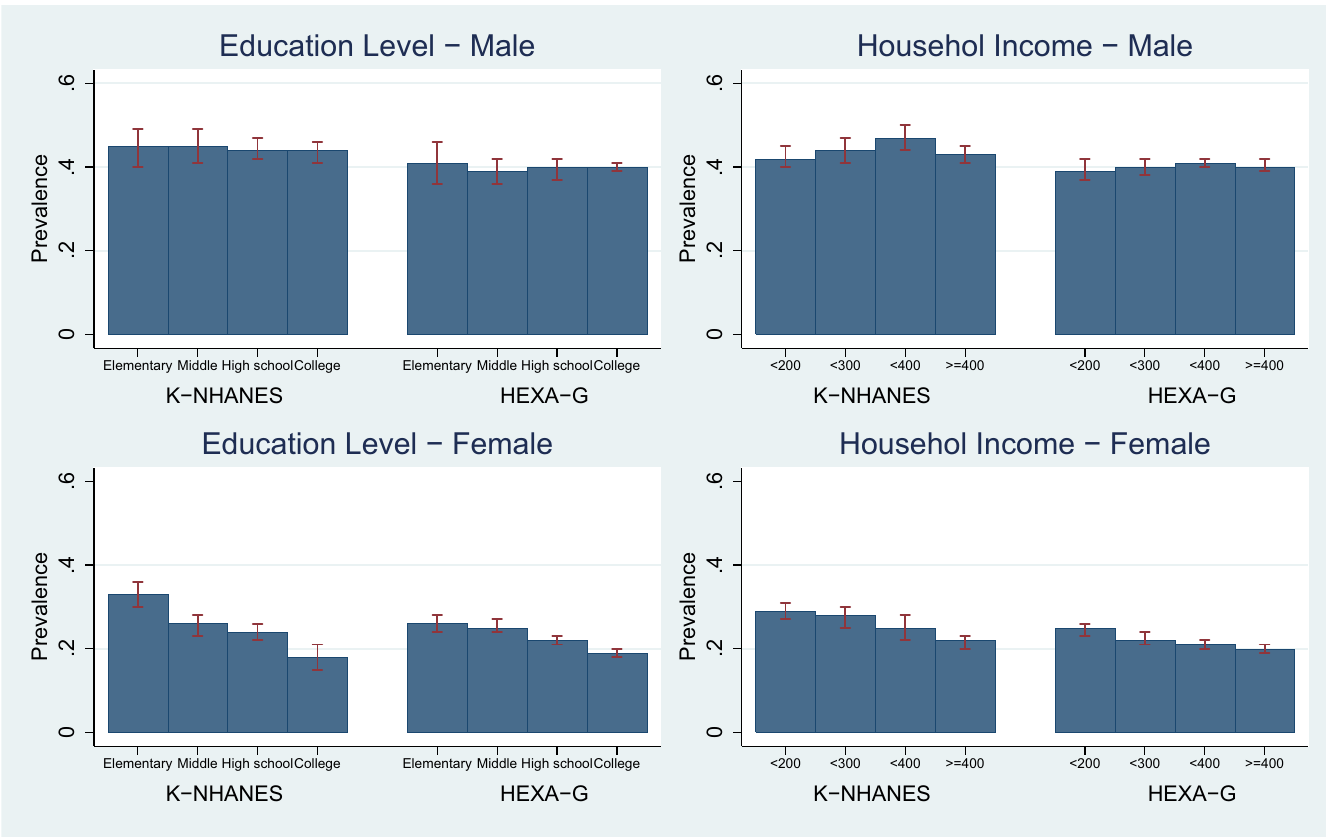
Fig 2. Age-standardized prevalence: Elevated triglycerides. K-NHANES: Korea National Health and Nutrition Examination Survey; HEXA-G: Health Examinees- Gem. Elevated triglycerides (cid:21) 150 mg/dL (1.7 mmol/L) or specific treatment for this lipid abnormality.